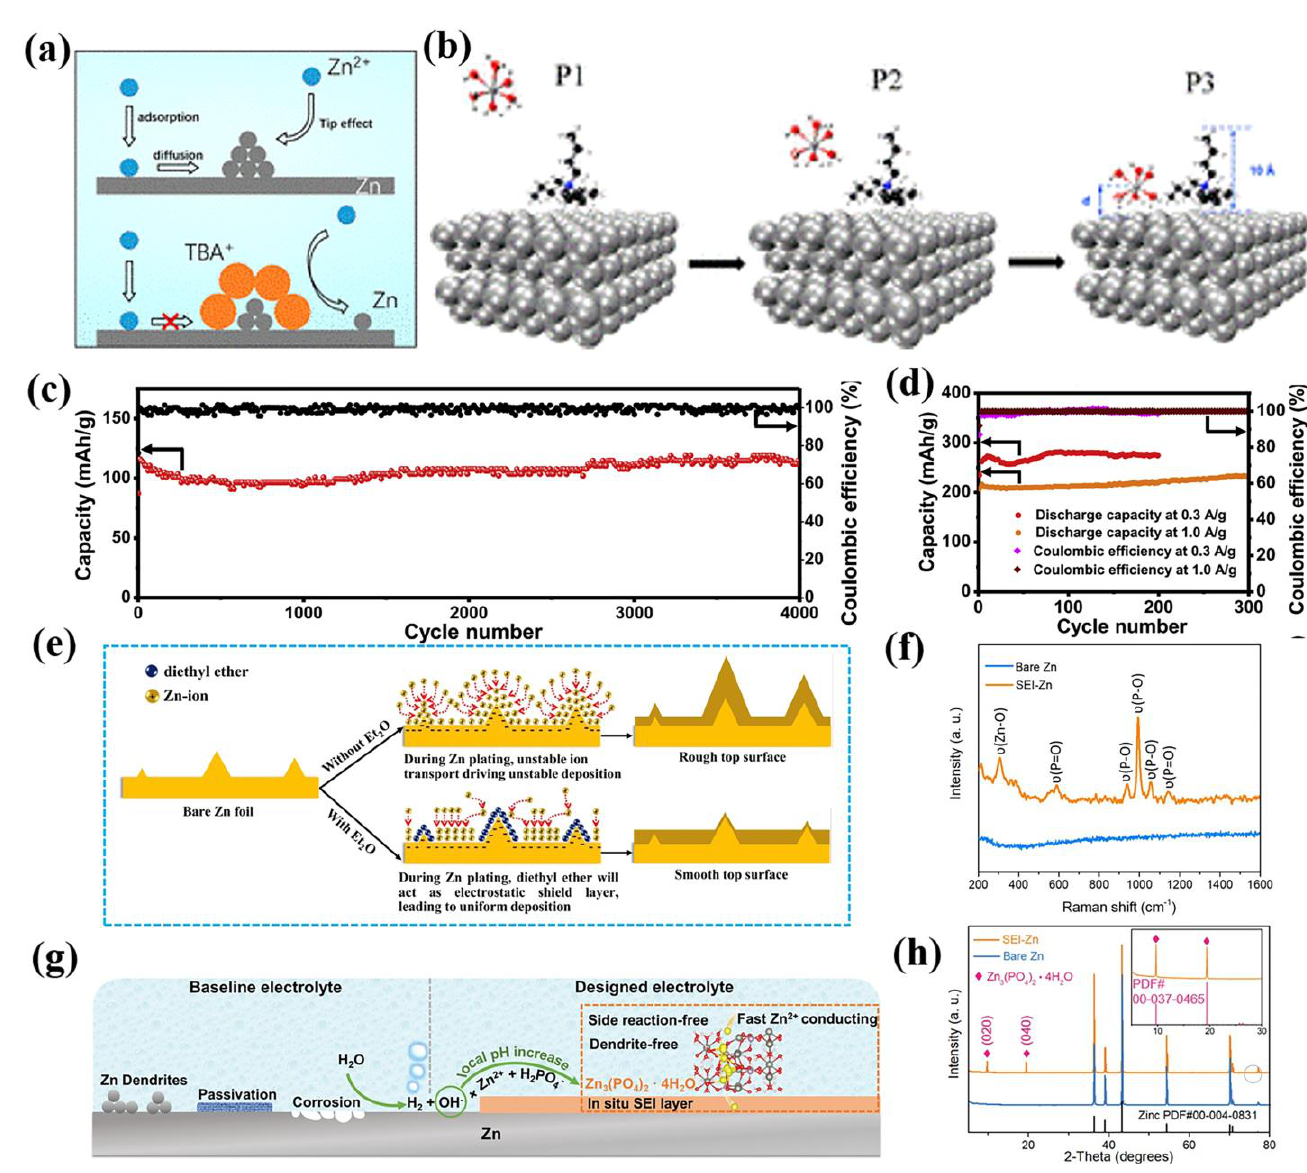
Figure 6. ( a ) Schematics of the Zn 2+ ion diffusion and reduction processes on electrodes in ZnSO 4 electrolyte (upper part) and ZnSO 4 electrolyte with TBA 2 SO 4 (lower part). ( b ) Model of DFT calculations, showing a hydrated Zn 2+ ion passing through the TBA + cation adsorption layer on a Zn surface. Adapted with permission from Ref. [71]. Copyright 2020 American Chemical Society. ( c ) Long − term cycling performance of Zn − MnO 2 battery with Et 2 O additive at 5 A g −1 . ( d ) Cycling performances of Zn||MnO 2 battery with Et 2 O additive at 0.3 A g −1 and 1 A g −1 . ( e ) Schematics of morphology evolution for Zn anodes with and without Et 2 O additive. Adapted with permission from Ref. [62]. Copyright 2019 Nano Energy. ( f ) Raman spectra of the SEI − Zn electrode and bare Zn. ( g ) Schematic illustration of the Zn surface evolution and (h) XRD patterns of Zn electrode before and after 20 cycles in the Zn(H 2 PO 4 ) 2 + Zn(CF 3 SO 3 ) 2 . Adapted with permission from Ref. [63]. Copyright 2021 Advanced Materials.